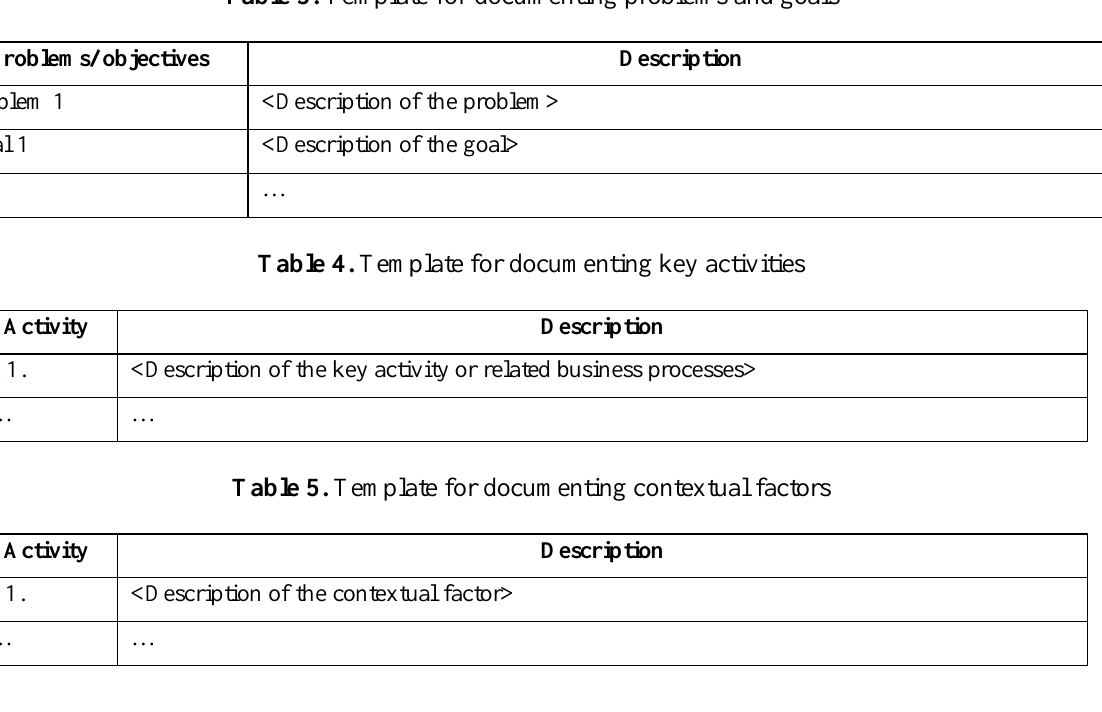
Table 3. Template for documenting problems and goals